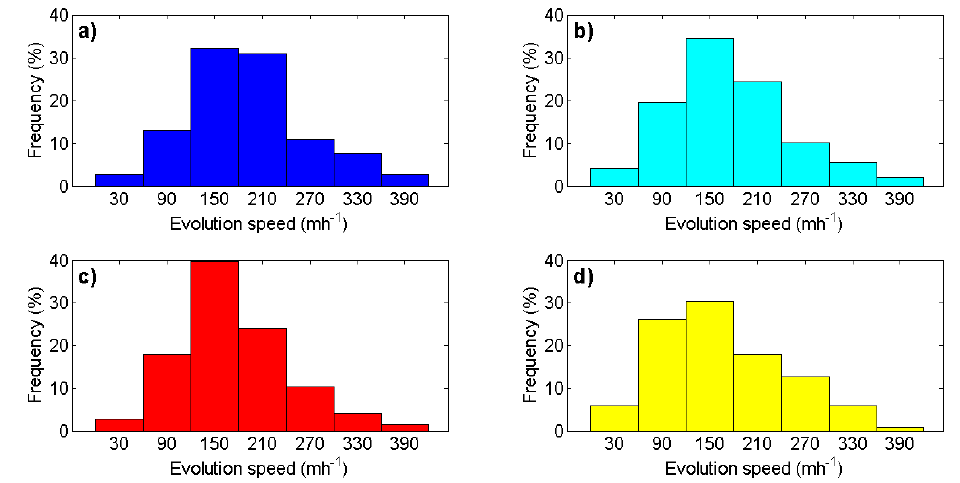
Fig. 11. PBL growth rates during the comparison period: (a) PollyXT, (b) ECMWF, (c) SAWS 2 and (d) TAPM.